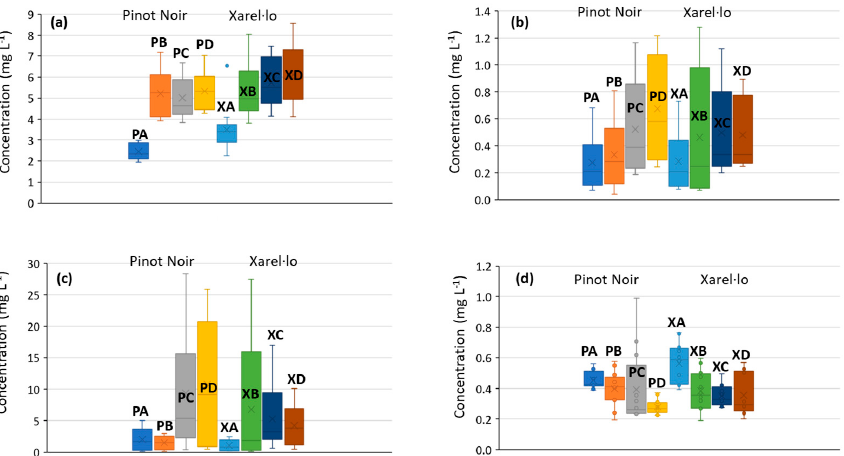
Figure 2. Boxplots depicting the evolution of the content of biogenic amines according to quality for the Pinot Noir and Xarel · lo varieties; ( a ) ethanolamine; ( b ) phenylethylamine; ( c ) putrescine; and ( d ) tryptamine. Sample assignation: A-type Pinot Noir (PA), B-type Pinot Noir (PB), C-type Pinot Noir (PC), D-type Pinot Noir (PD), A-type Xarel · lo (XA), B-type Xarel · lo (XB), C-type Xarel · lo